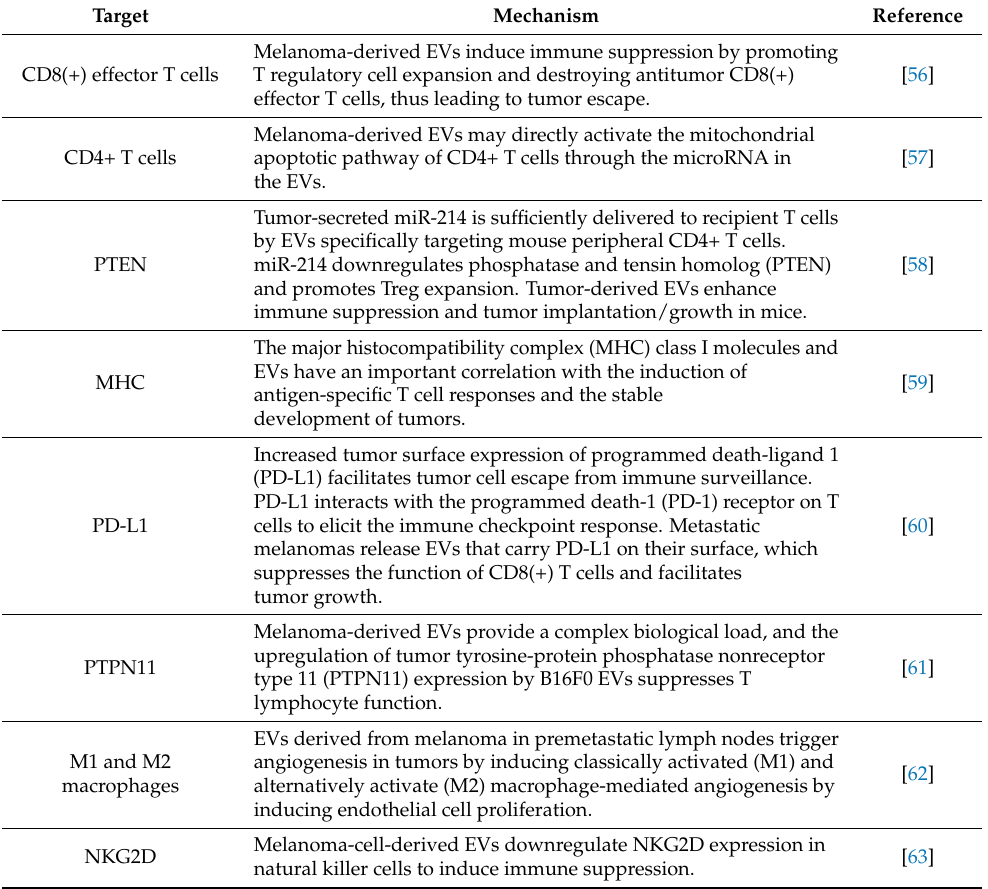
Table 2. The effect of tumor-derived EVs in immune